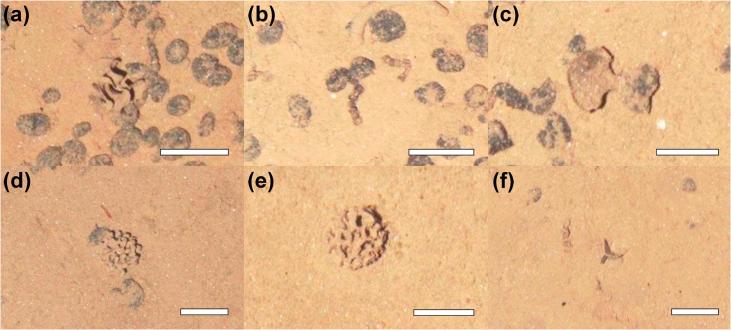
Examples of xenophyophore megafauna photographed at the APEI6 seafloor during AUV survey. Scale bars representing 50 mm. (a) Reticulammina msp. (b) Aschemonella monile. (c) Fan-shaped Psammina msp. (d) Indeterminate Psamminid msp, possibly Shinkaiya or Syringammina. (e) Syringammina cf. limosa. (f) Triradiate Psammina msp, possibly P. multiloculata.